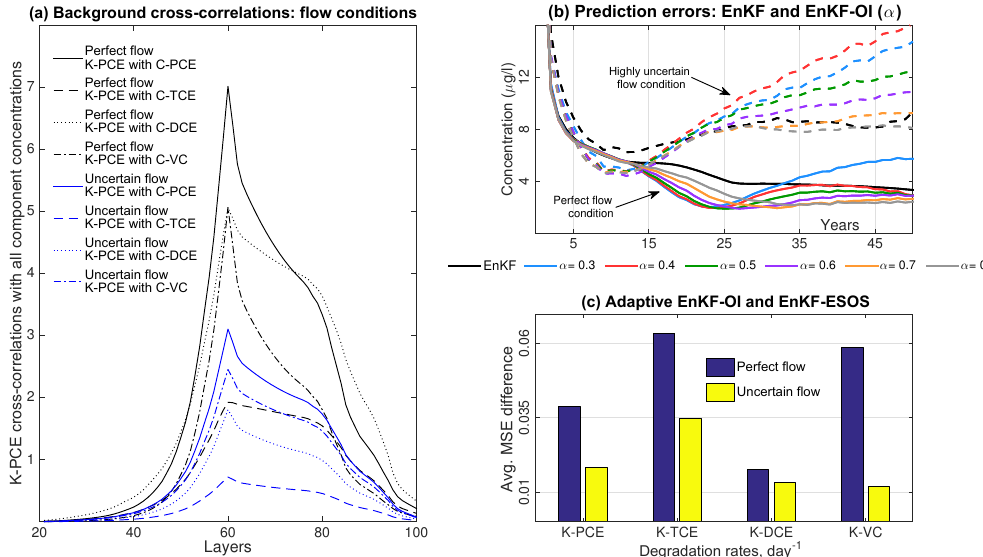
Figure 15. (a) Cross-correlation terms of the background matrix P b associated with PCE biodegradation rate and all components’ con- θx centrations. The spatial correlations are averaged for all layers. The correlations in black are based on perfect groundwater-flow model. The correlations in blue are constructed after perturbing the hydraulic conductivity and porosity of the forecast model. The largest correla- = 1 . 0 tion is present in layer 60 where the contaminant source is located. (b) Performance of the EnKF and the hybrid EnKF-OI β α = 0 . 3 , 0 . 4 ,..., 0 . 8 before and after perturbing the hydraulic conductivity and porosity. The performance is assessed based on the temporal evolution of the MSE (prediction) errors. The imposed Gaussian uncertainty is high and obtained using standard deviation σ h . (c) Average gain (cid:0) MSE (cid:1) suggested for all degradation parameters. The improvements suggested by the adaptive EnKF- P 50 1 − MSE EnKF − OI EnKF − ESOS i = 1 50 OI over EnKF ESOS are shown for both perfect and perturbed (using σ m ) flow